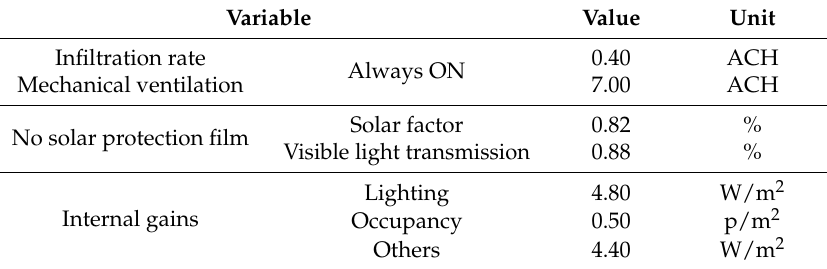
Table 4. Other considerations for the energy simulation model. Source: